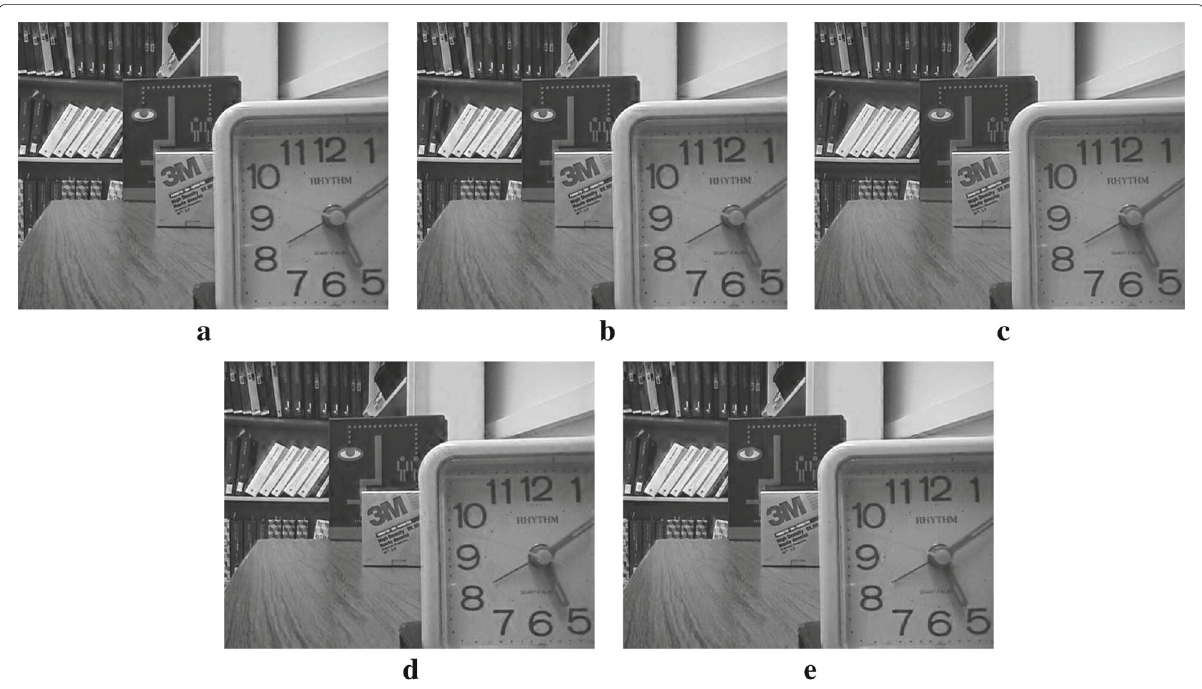
Fig. 16 Fusion results for a multi-focus image pair. a The LP. b The DWT. c The CVT. d The CT. e The